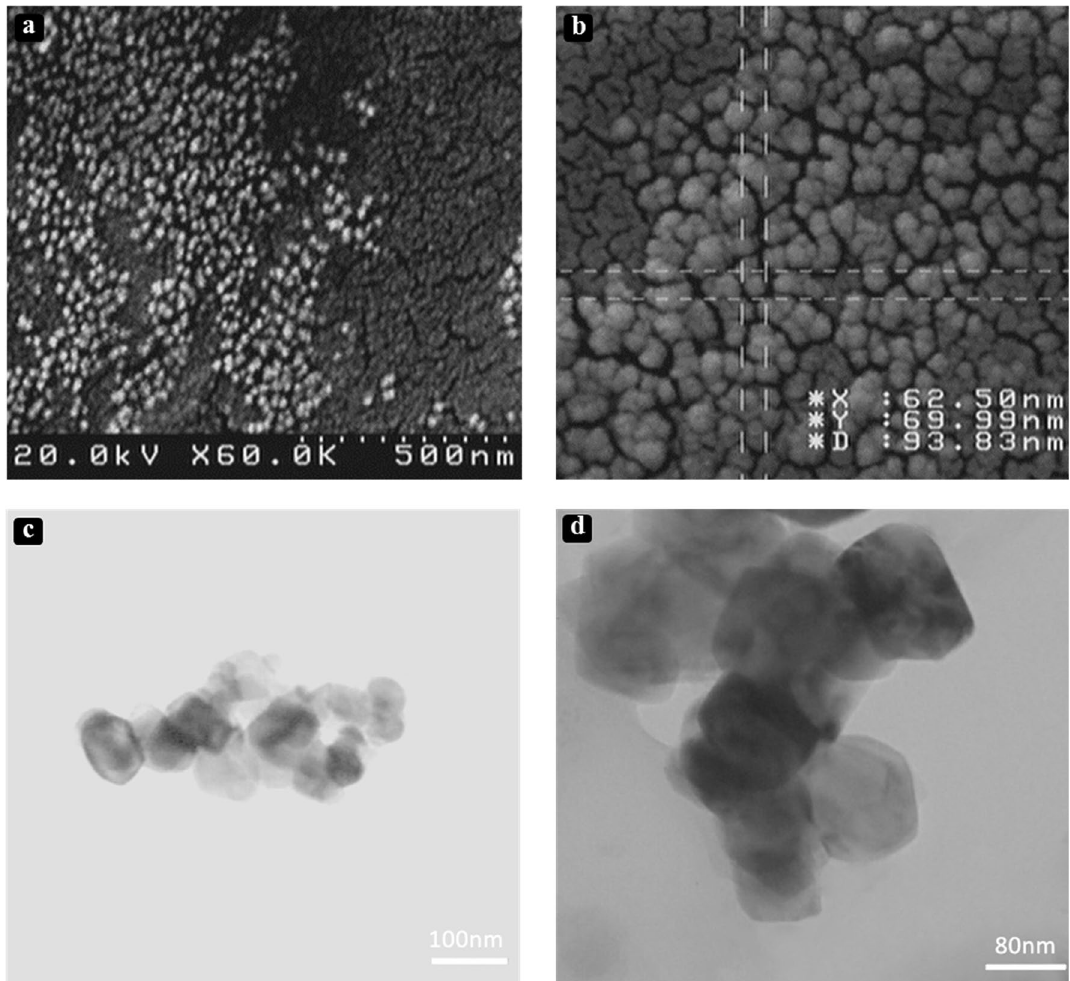
Figure 5. EM imaging of CUR-loaded LNDNG. Images of ( a ) and ( b ) refer to SEM micrographs and those of ( c ) and ( d ) belong to TEM